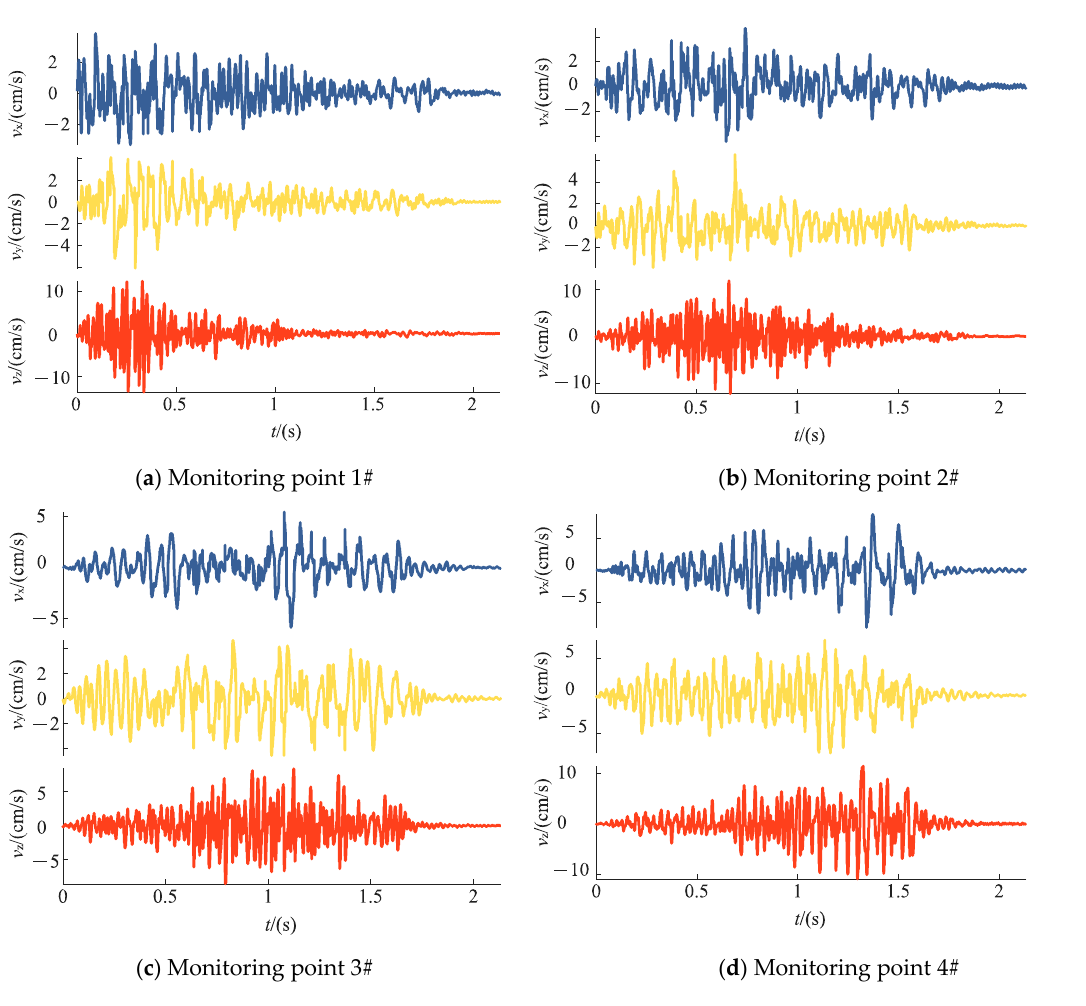
Figure 7. Particle velocity waveform of Test 1.